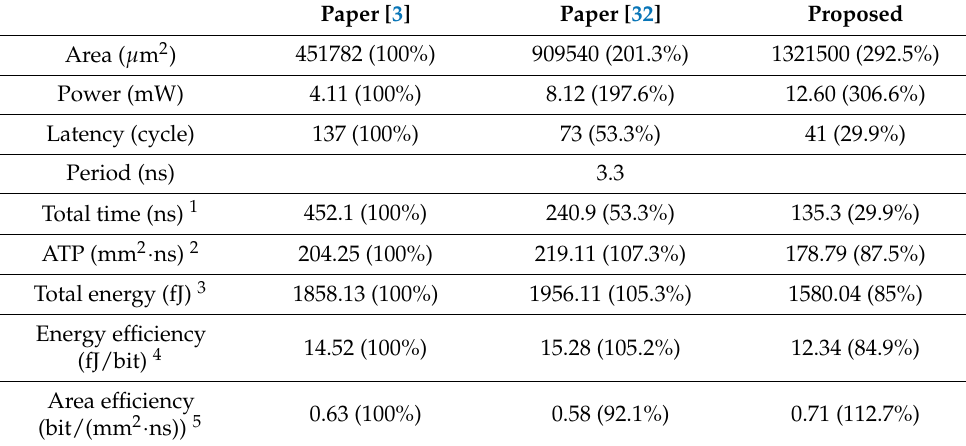
Table 5. Comparison of ASIC implementation details @ TSMC 65 nm. Paper [3] Paper